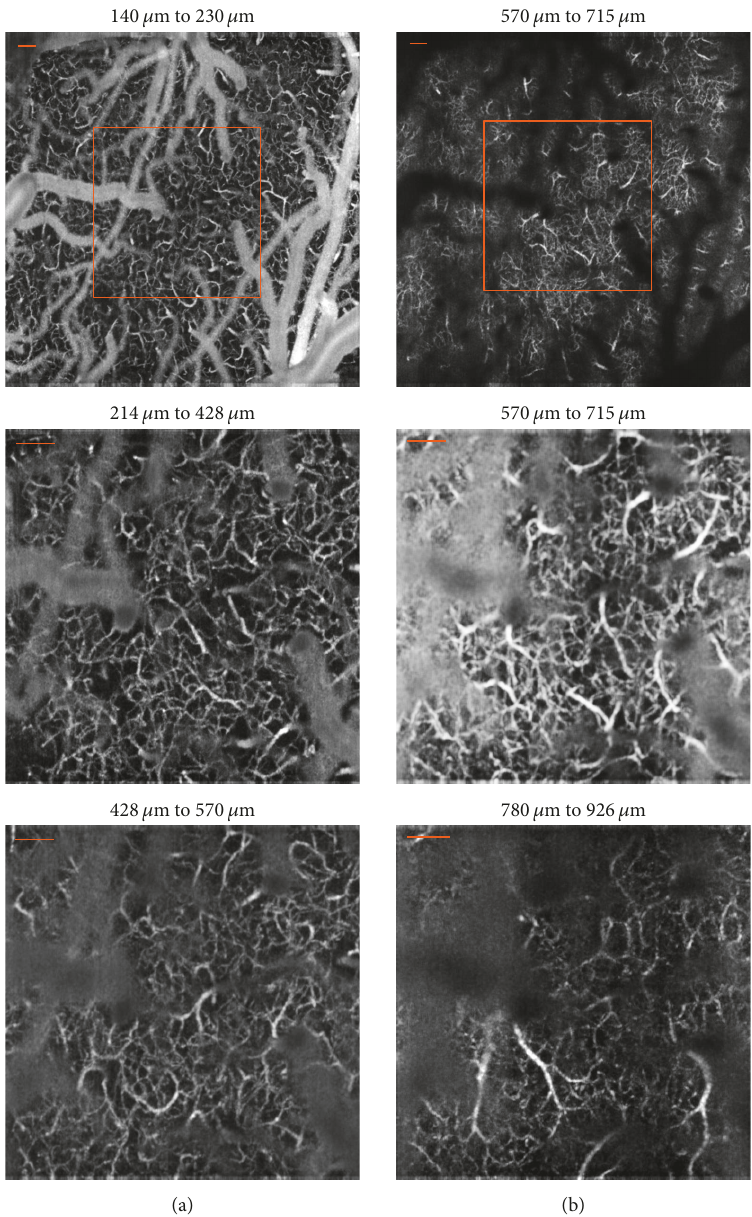
Figure 12: Deep brain imaging. The system is able to image vasculature up to 900 𝜇 m deep in the brain of a rat. When imaging deep regions of a brain, the large pial vessels on the surface block the OCT beam and create dark and noisy areas in the OCT angiography images. (a) and (b) are obtained from the same region but at different depths. The shadow of the superficial vessels on (a) prevents imaging the capillaries at deeper regions that are shown on (b). The scale bars are 200 𝜇